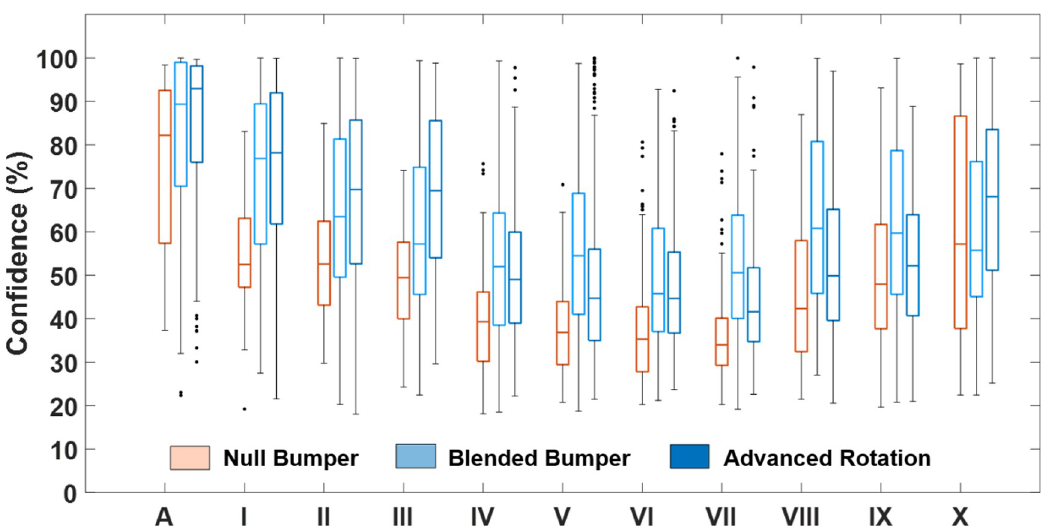
Fig 4. Confidence of NB, BB and AR trained cCNN across all output classes (A, I-X). Standard box and whisker levels are used with the center mark indicating the median, the bottom and top edges of the box indicating the 25th and 75th percentiles, respectively, the whiskers extending to the most extreme data points not considered outliers, and the outliers plotted individually.